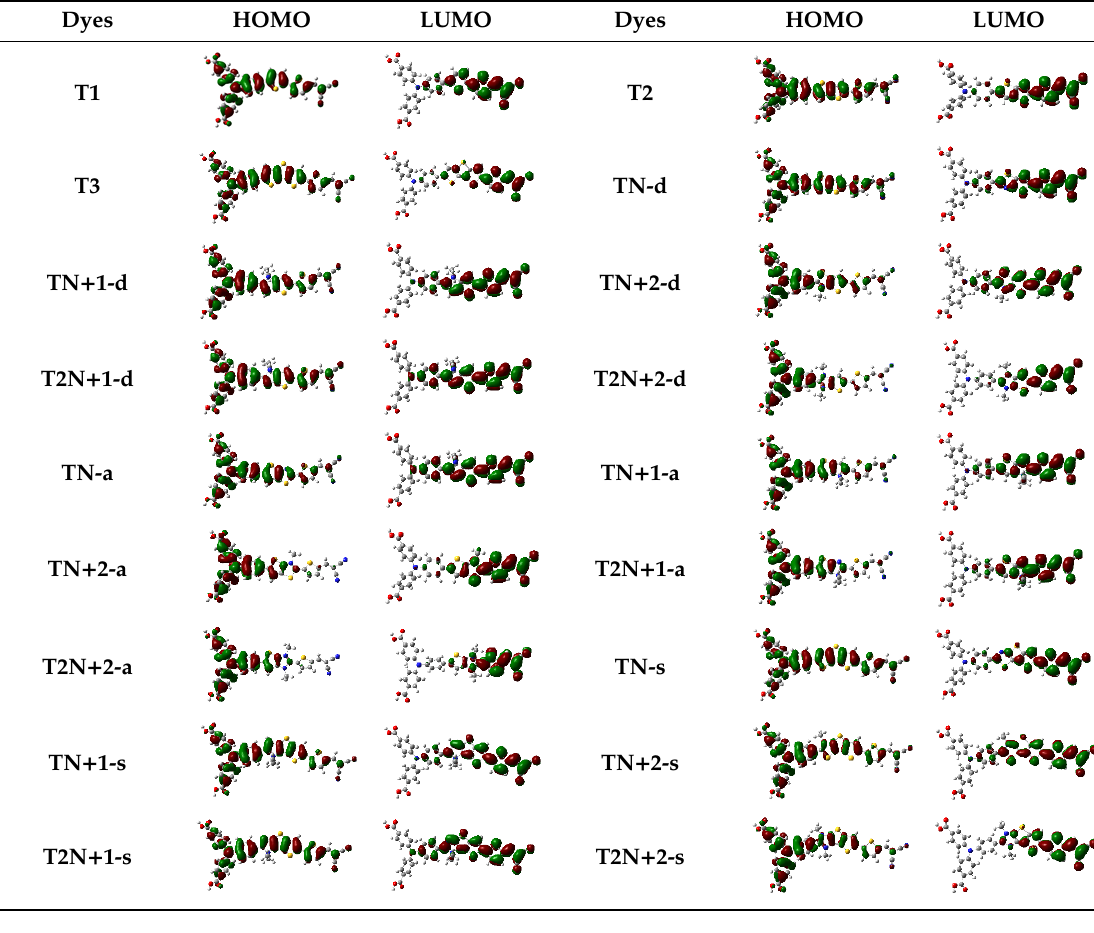
Table 1. Contours of molecular frontier orbitals of dyes.